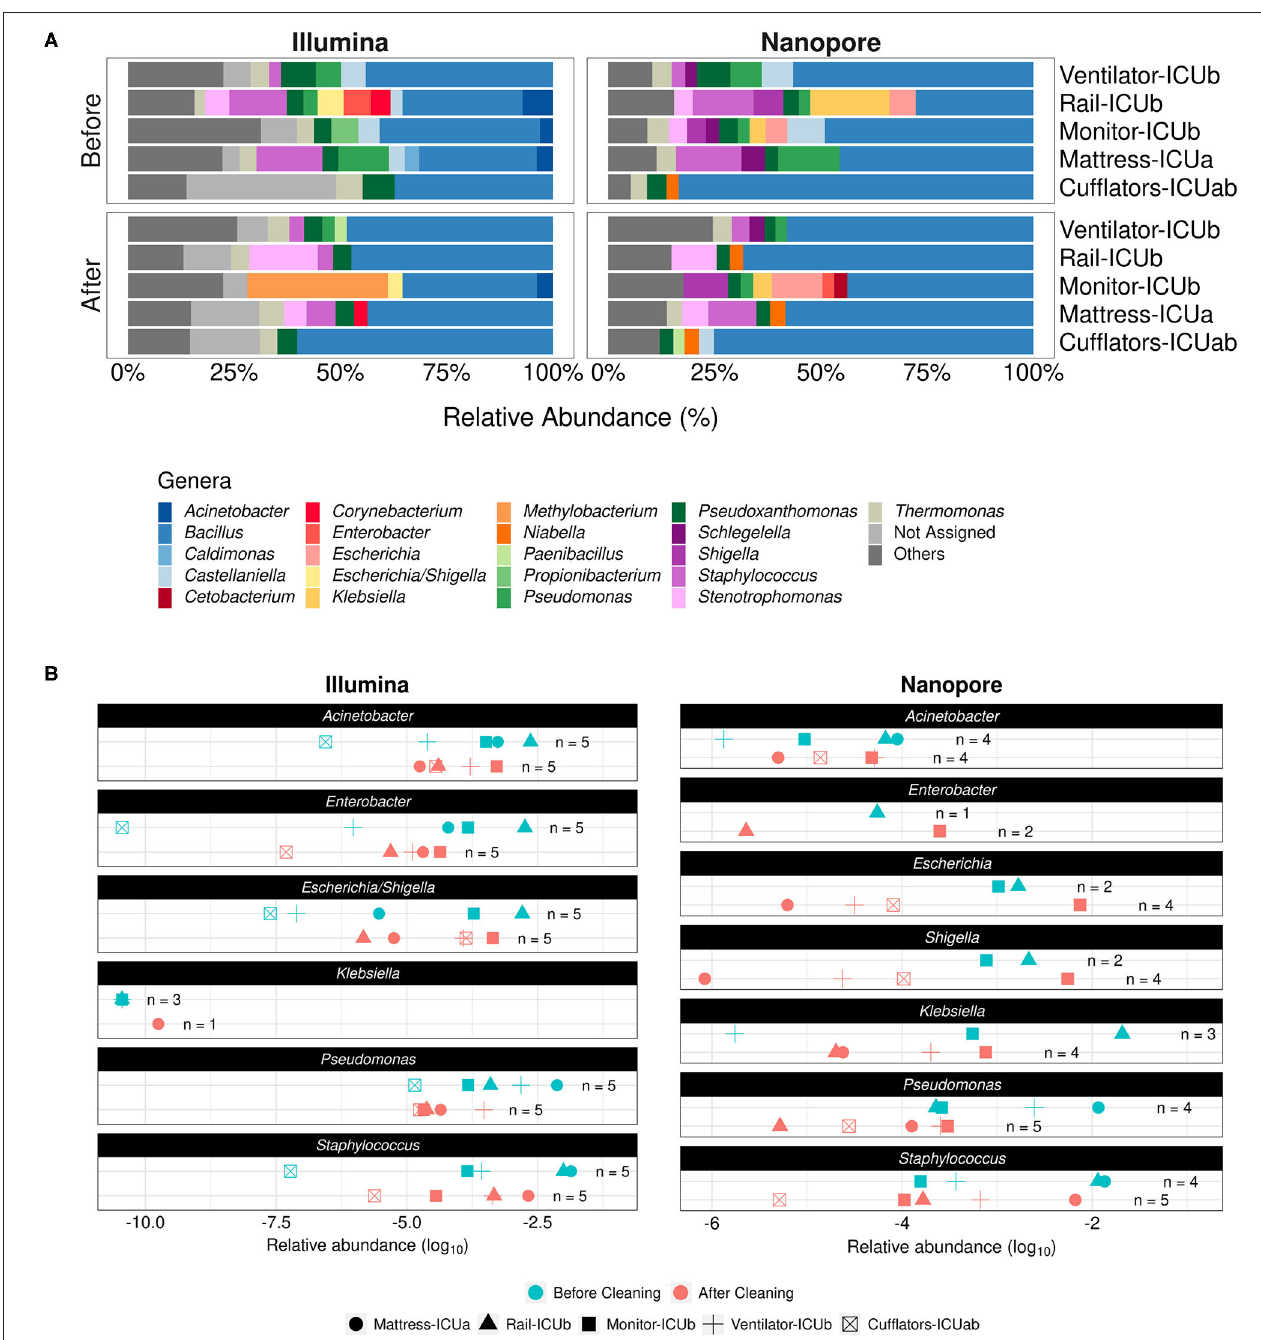
FIGURE 1 | Comparison of the effect of cleaning routines in the ICU microbial profiles according to Illumina and Nanopore sequencing. (A) Stacked bar plots depicting main genera detected in ICU samples collected before and after concurrent cleaning with both approaches. Genera with relative abundances below 2.5% were grouped under the label “Others.” (B) Dot plots showing the relative abundances of specific HAI-related organisms in different samples (represented by different shapes in the plots) before (cyan) or after (red) cleaning, as detected by both sequencing methods. The number of samples in which each of the genera was found ( n ) is shown in the